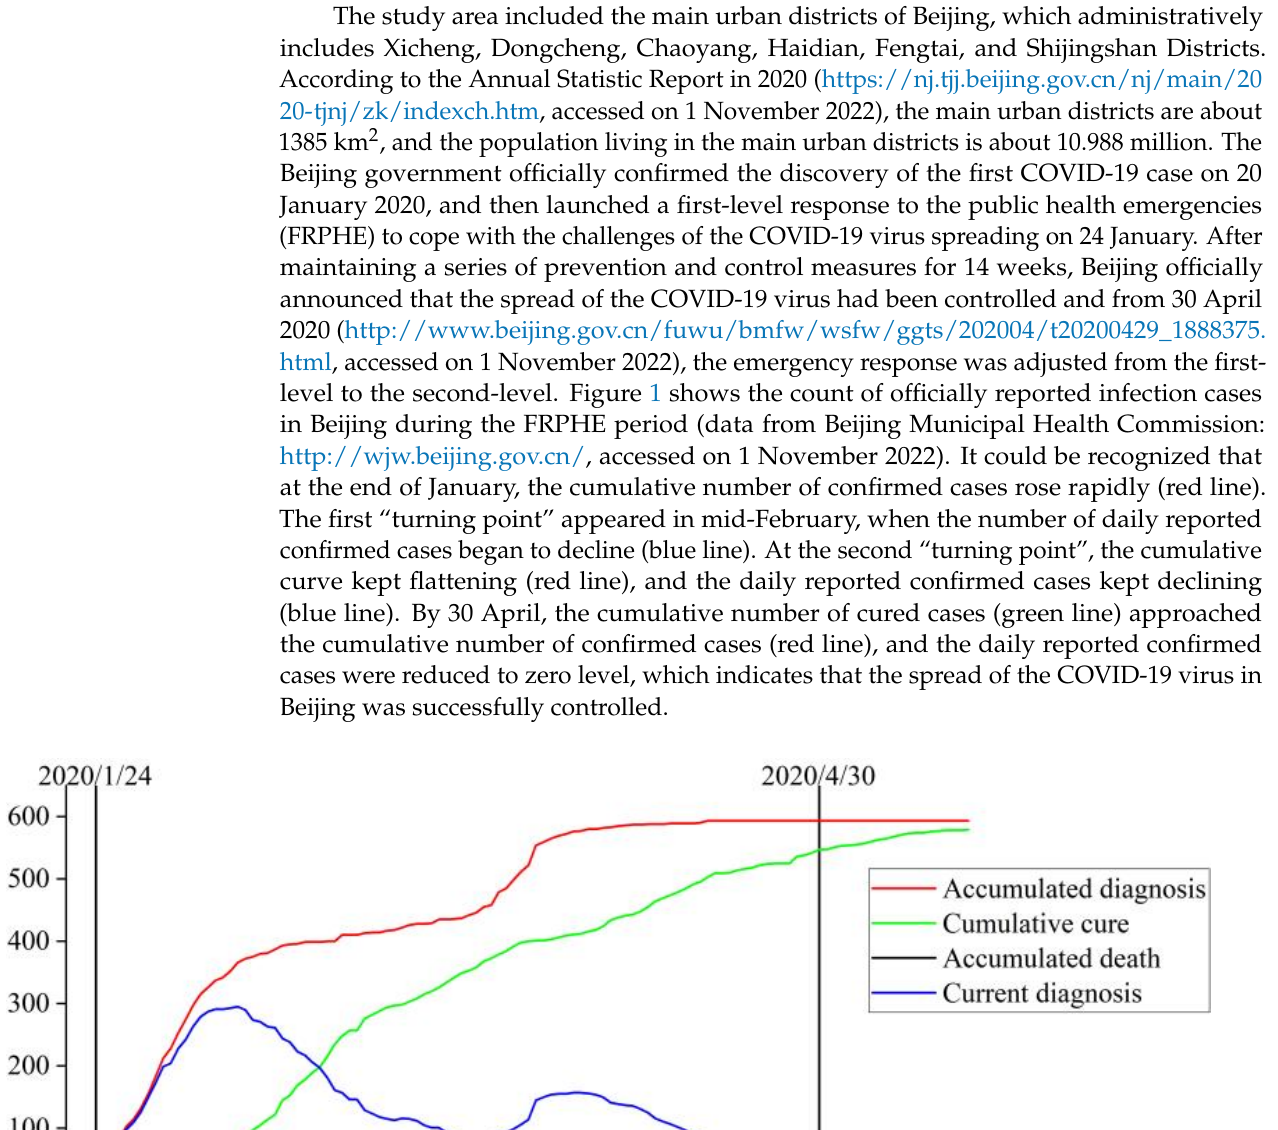
Table 1. The COVID-19 prevention and control measures implemented in urban facilities in Beijing. Urban Facilities